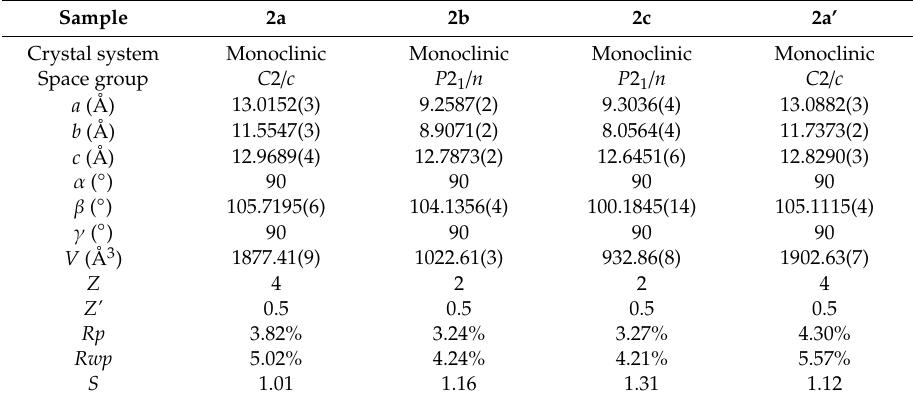
Figure 7. Results of Rietveld refinements for the 2a, 2b, 2c, and 2a’ . Data are plotted as in Figure 3. Table 2. Crystallographic data of samples of 2a , 2b , 2c , and 2a’ .